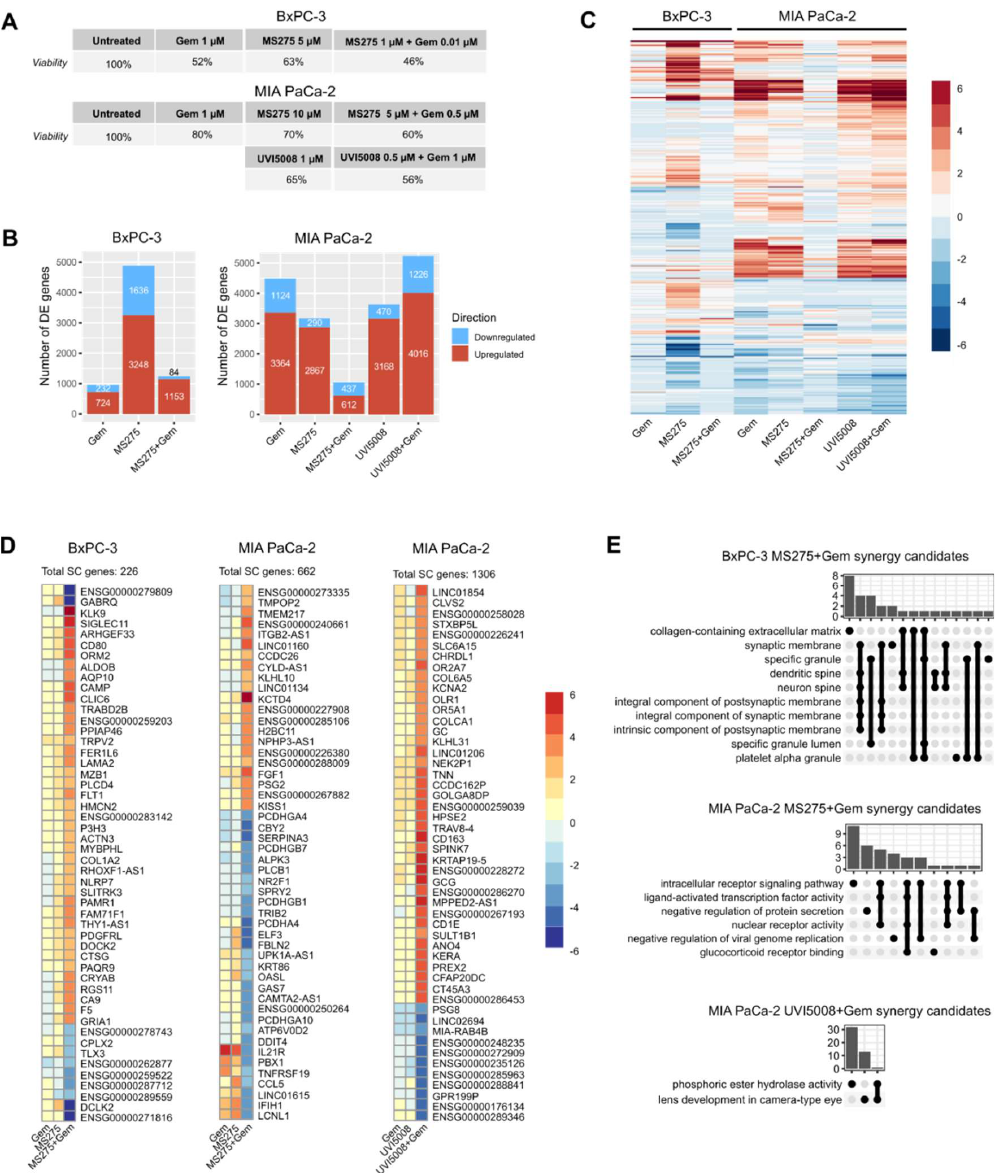
Figure 5. Transcriptome analysis of the synergistic effect of gemcitabine (Gem) with MS275 on BxPC−3 and MIA PaCa−2 cells, and with UVI5008 on MIA PaCa−2 cells. Drug combinations and doses selected for RNA-Seq analysis and percentages of cell viability ( A ). Number of upregulated (red) and downregulated (blue) genes induced by treatments when compared to untreated control ( B ). Heatmap representation of all differentially expressed genes induced by treatments when compared to untreated control ( C ). Top 50 of synergy candidate (SC) genes ordered by fold change in each treatment combination ( D ). Genes are colored according to their expression levels. Top 10 over- representation analysis of synergy candidate genes using Gene Ontology ( E ). Bars represent the number of genes in the intersection among terms.